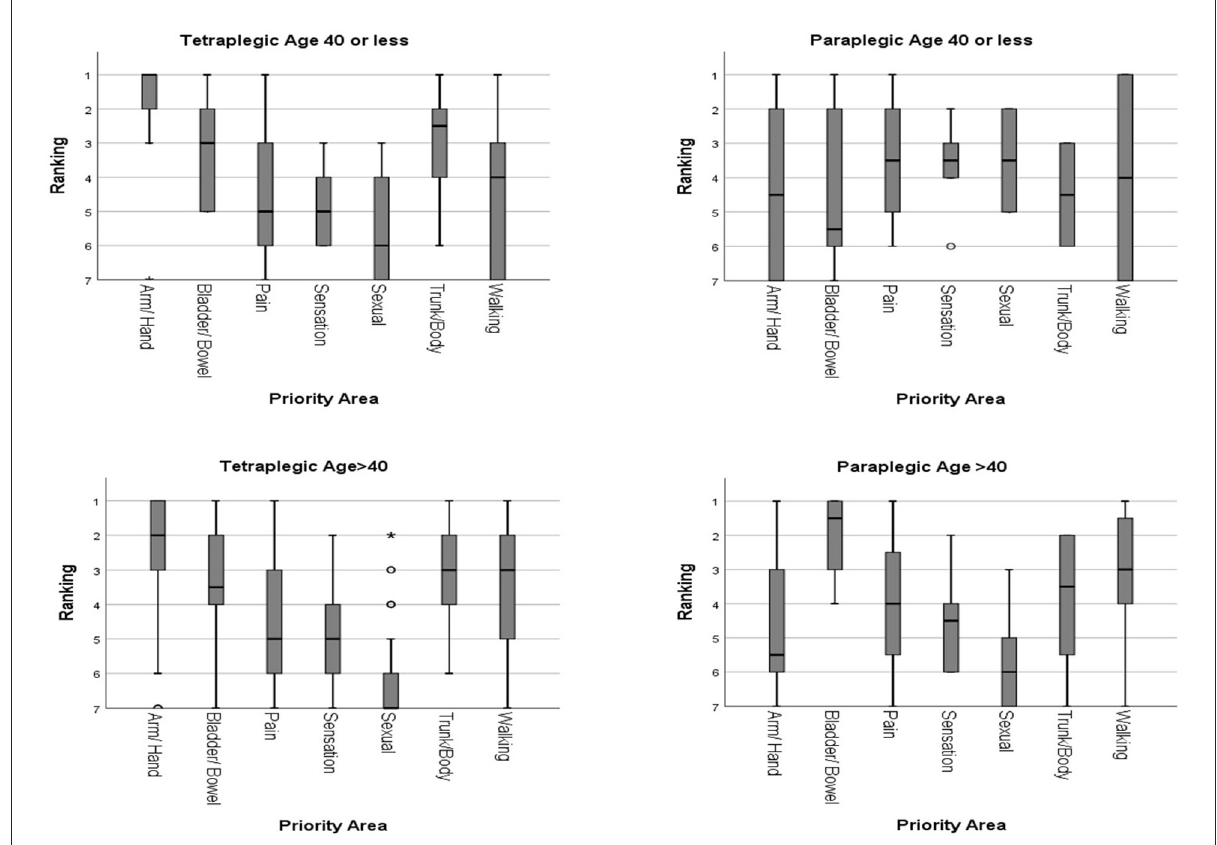
FIGURE4 Rankings of the priority areas of functional recovery according to age.